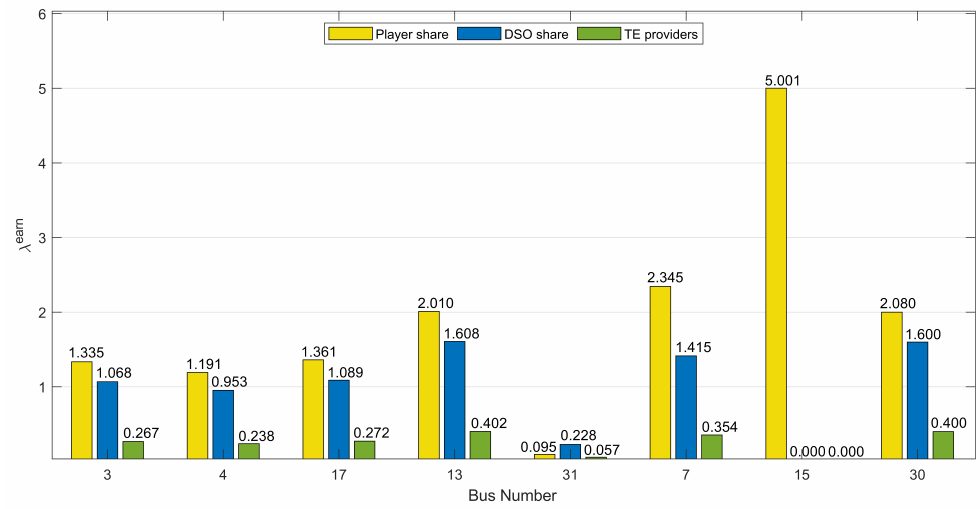
Figure 7. Scheduling Marginal Earn